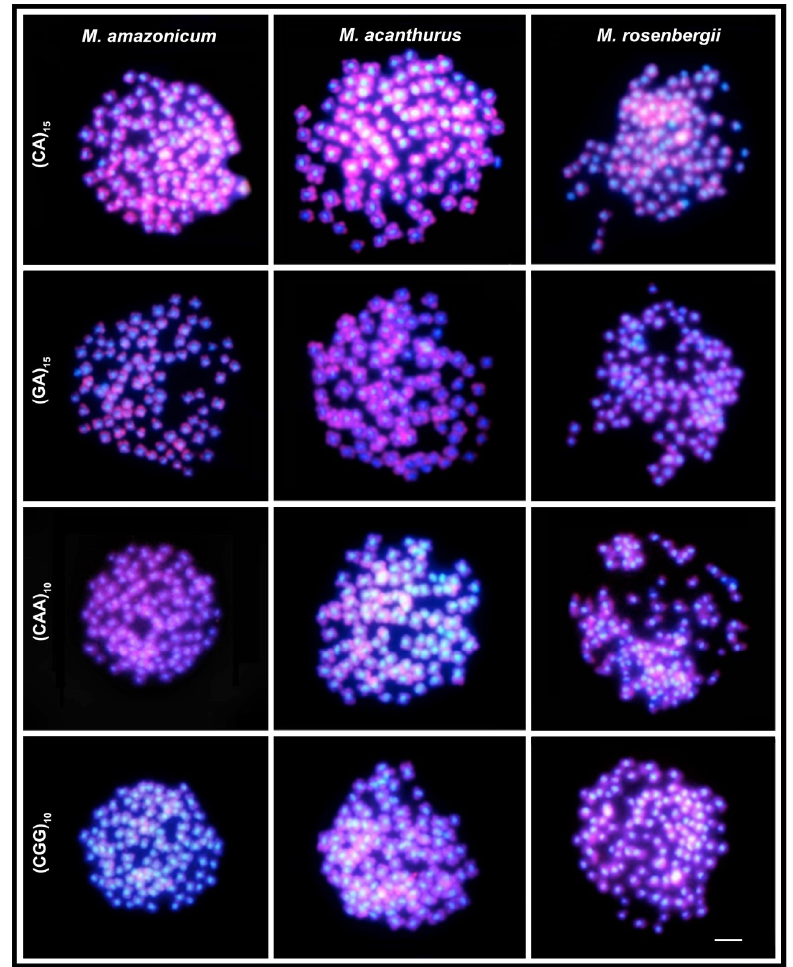
Figure 2. Fluorescence in situ hybridization with microsatellite probes (red fluorescence) in spermatogonial metaphases of Macrobrachium species. Blue fluorescence represents chromosomes stained with DAPI. Bar = 5 µm.